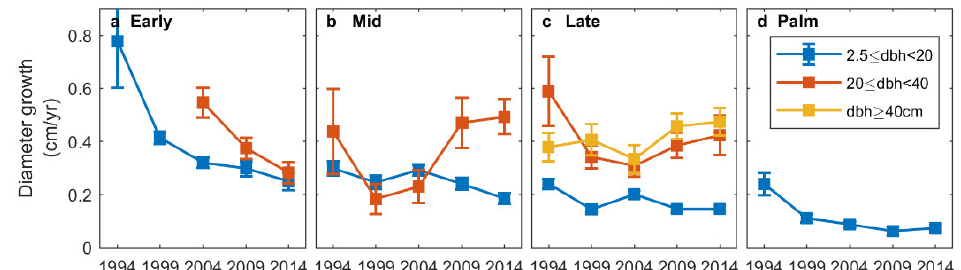
Figure 3. Diameter growth rates (cm per year) in five censuses for each diameter (DBH) size of ( a ) Early , ( b ) Mid , ( c ) Late , and ( d ) Palm PFTs. The markers and the bars indicate the mean and standard error, respectively; only values with more than 10 samples are shown.